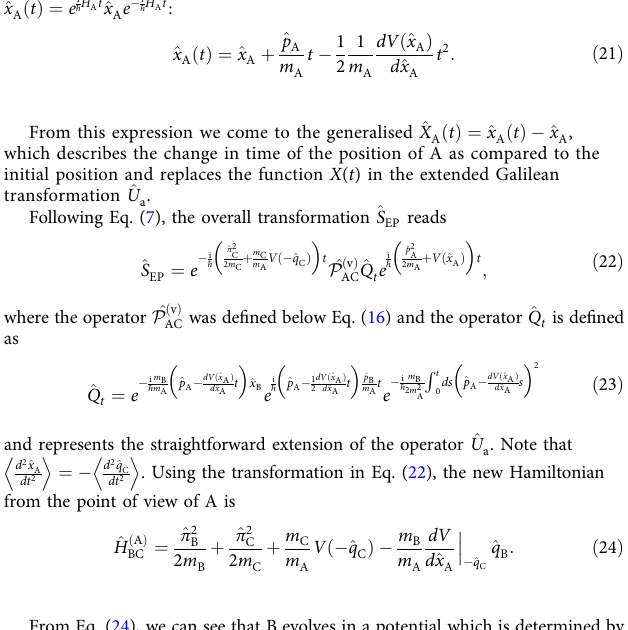
Fig. 6 Generalisation of the weak equivalence principle for quantum reference frames. The quantum system A is initially in a superposition of two localised wave amplitudes in a piecewise linear potential V ð ^ x the point of view of another system C. The individual wave amplitudes are localised in spatial intervals corresponding to two different potential gradients. The system B evolves instead as a free particle. If we consider the motion for suf fi ciently short times, such that the two amplitudes remain localised within the corresponding intervals, the system A evolves as if it were in a superposition of the accelerations a 1 and a 2 . We can then change perspective to the accelerated reference frame of A, by applying a transformation corresponding to a ‘ superposition of accelerations ’ , and describe how the quantum system A sees the quantum systems B and C and their evolution. After the transformation, the system B evolves as if it was moving in a superposition of linear gravitational potentials, where the gravitational accelerations are such that ~ g i ¼ (cid:2) ~ a i , where i ¼ 1 ; 2. This means that the effects of a superposition of accelerations are indistinguishable from the effects of a superposition of gravitational fi elds